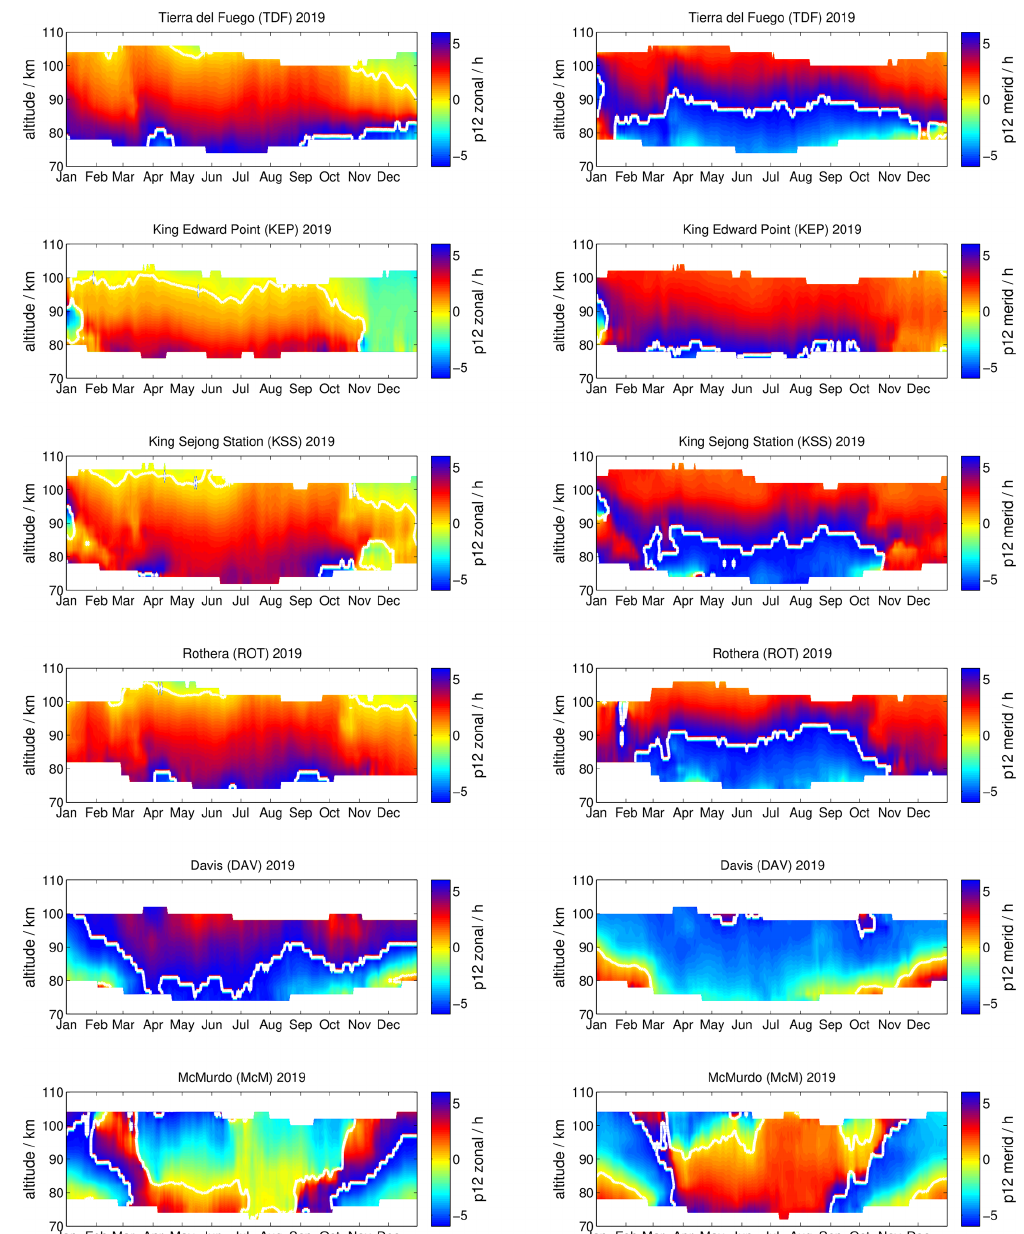
Figure 6. Same as Fig. 2 but for the semidiurnal tidal